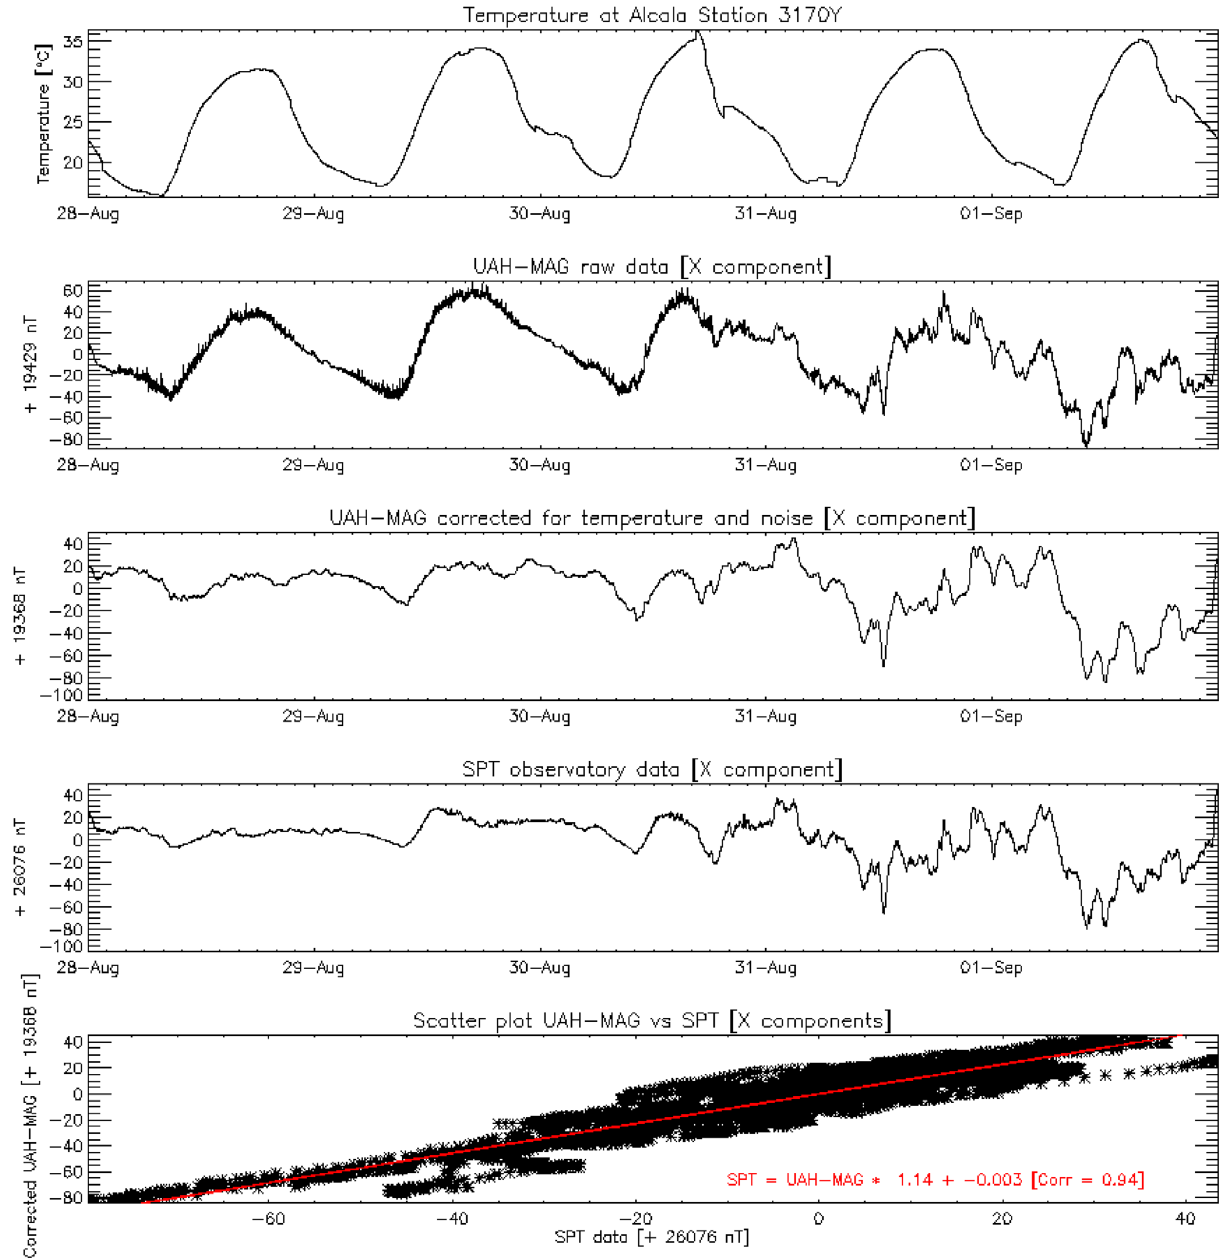
Fig. 6. Comparison of the 5 days of recordings from UAH-MAG and SPT observatory during a geomagnetic event. From top to bottom: temperature recorded at a weather station (3170Y), the recorded raw data from the magnetometer sensor, magnetometer signal corrected for temperature and noise, data from SPT observatory and scatter plot of UAH-MAG vs. SPT data with the regression fi tting line and parameters